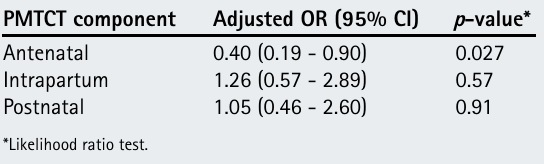
TABLE III. MULTIVARIABLE ANALYSIS